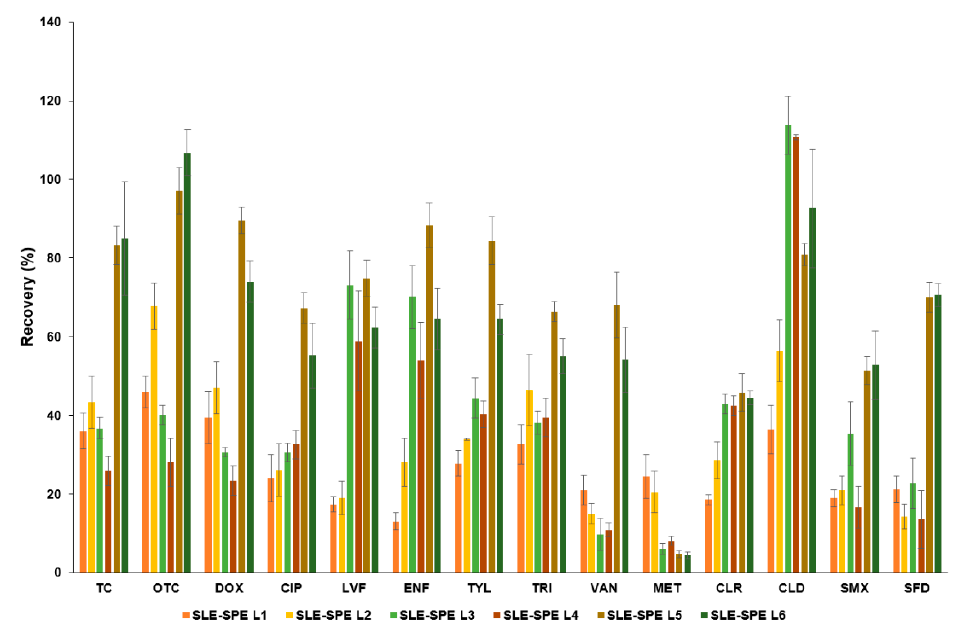
Figure 1. Comparison of the efficiency of FCs’ extraction process following SLE-SPE procedure from parsley leaf.